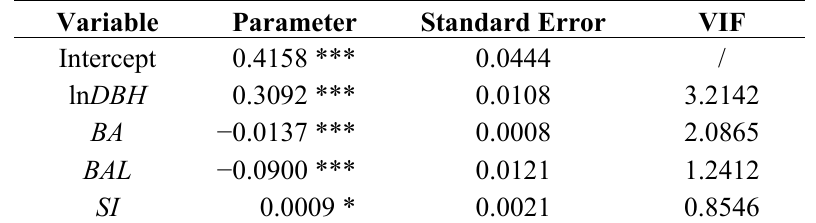
Table 3. The statistical analysis results for first-stage equations of individual-tree diameter growth model for Mongolian oak ( n = 10,698).